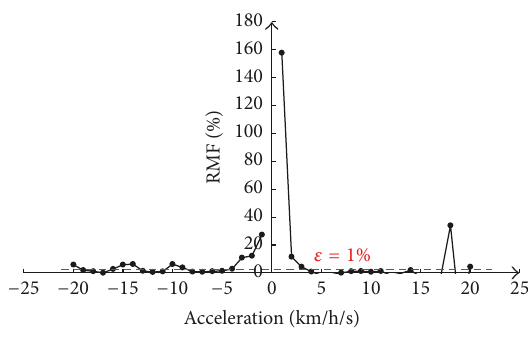
Figure 4: RMF of